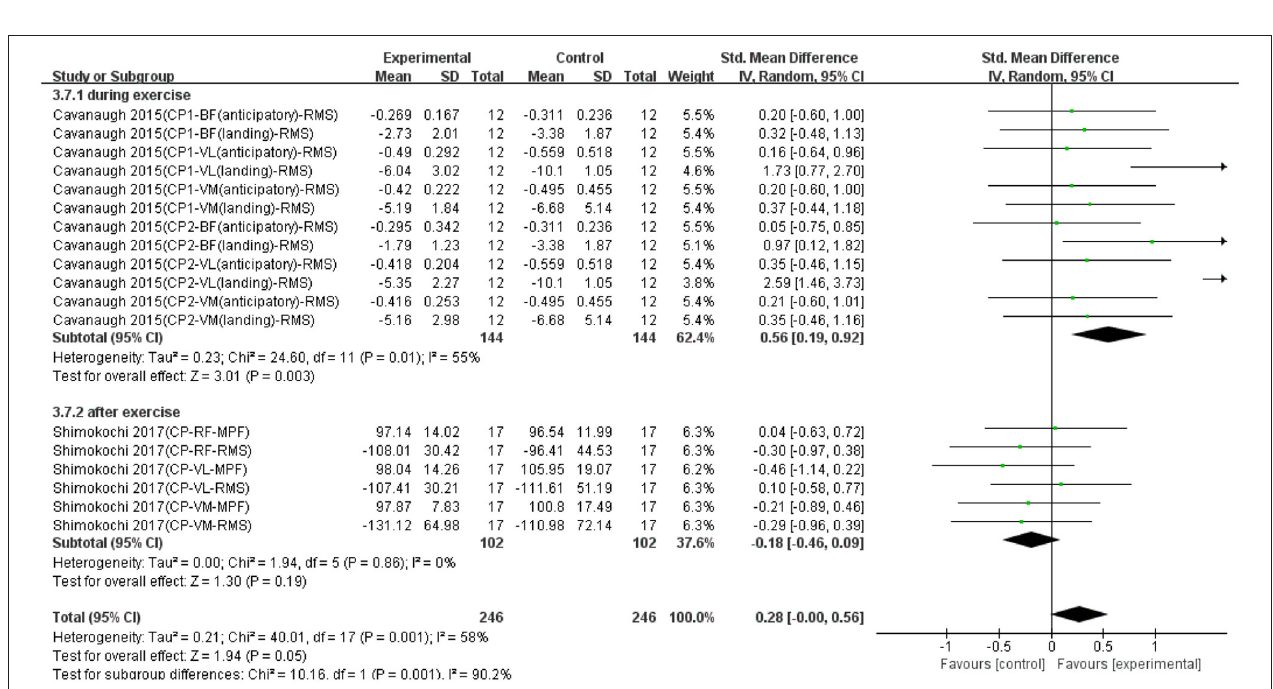
FIGURE 6 | The effectiveness of compression (CP) conducted at different time points on electromyography (EMG) signals of exercise-induced muscle fatigue.